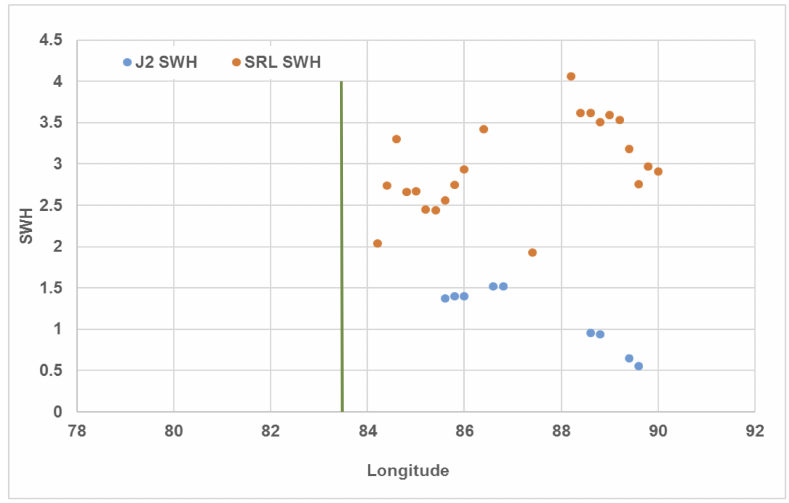
Figure 12. Availability of valid SWH data from SARAL/Altika and Jason-2 for transect along 18 ◦ N showing better available data near coast marked by green line.